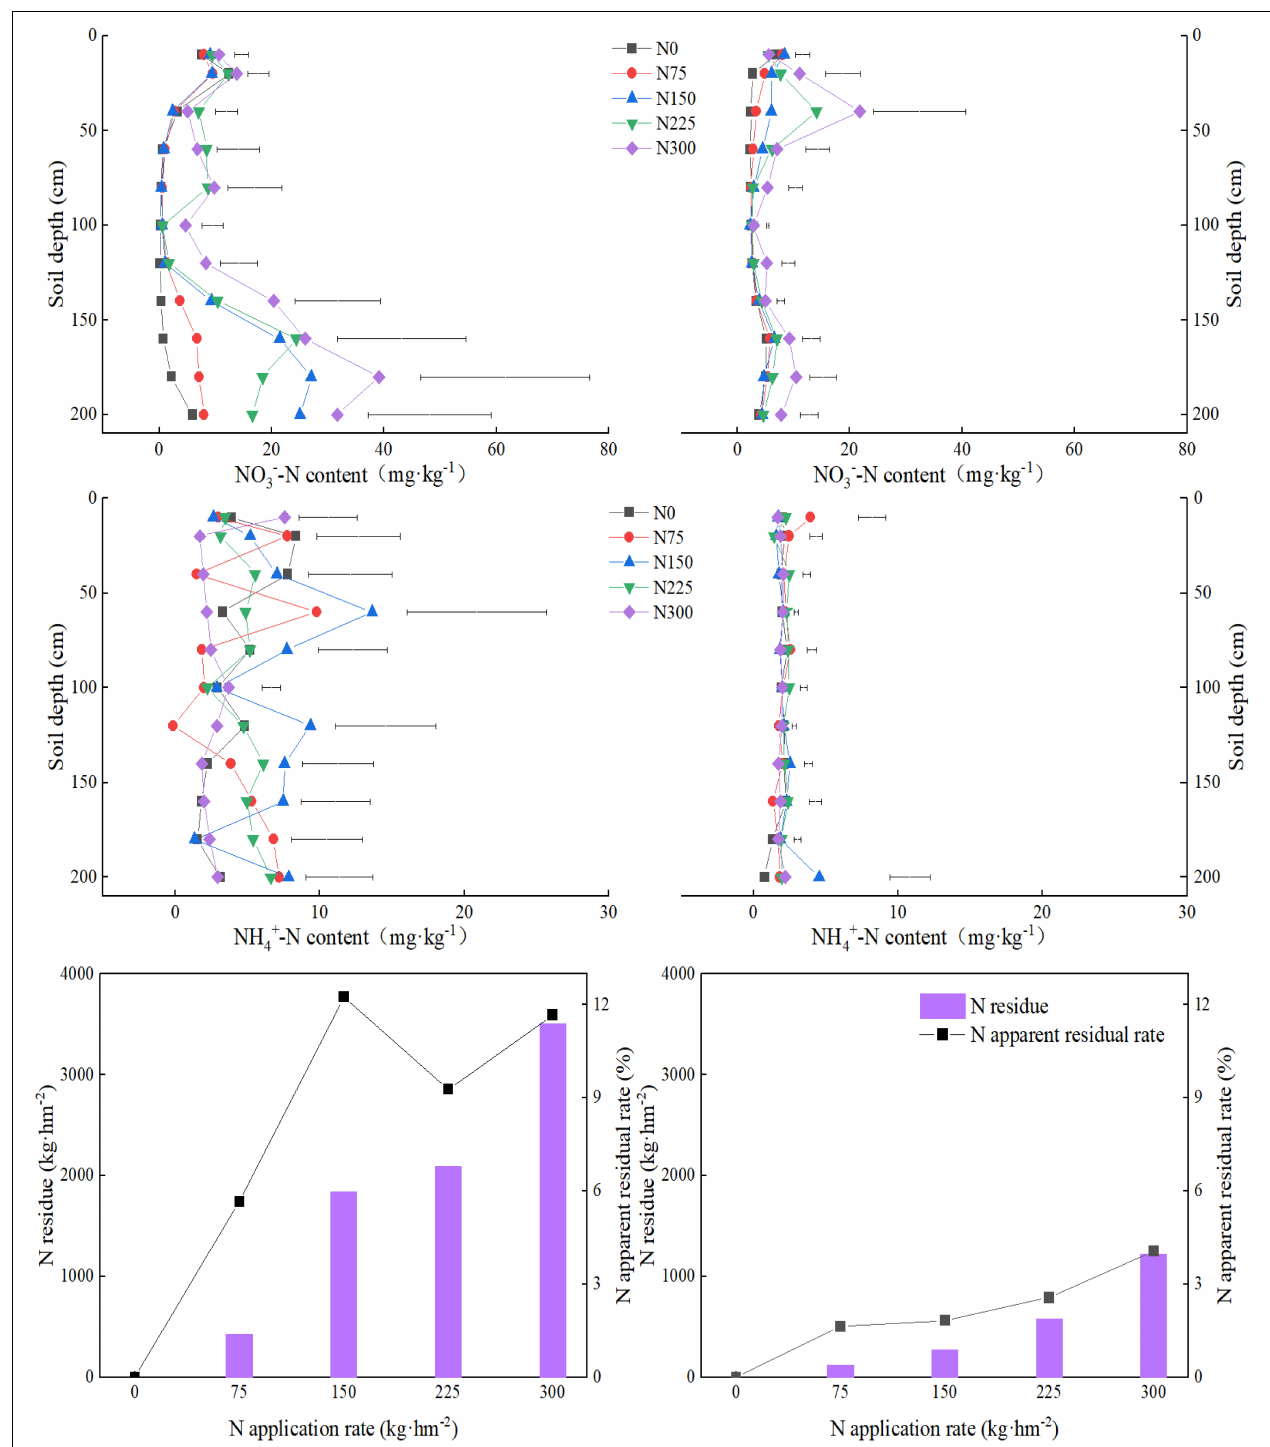
FIGURE 6 | Effect of different nitrogen (N) fertilization rates on NH 3 – -N, NH 4 + -N, residual N and N apparent residual rate in winter wheat during 2018 and 2019. The line segment is the LSD-t value obtained by multiple comparisons using the LSD-t method. N0: unfertilized control; N75: N application at 75 kg N · ha – 1 ; N150: N application at 150 kg N · ha – 1 ; N225: N application at 225 kg N · ha – 1 ; N300: traditional N application rate of 300 kg N · ha – 1 . The left-side figures show data for 2018, and the right-side figures show data for 2019.